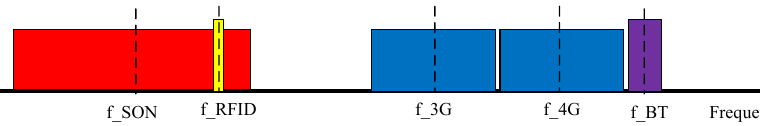
Figure 8. Spectrum division of the communication systems in